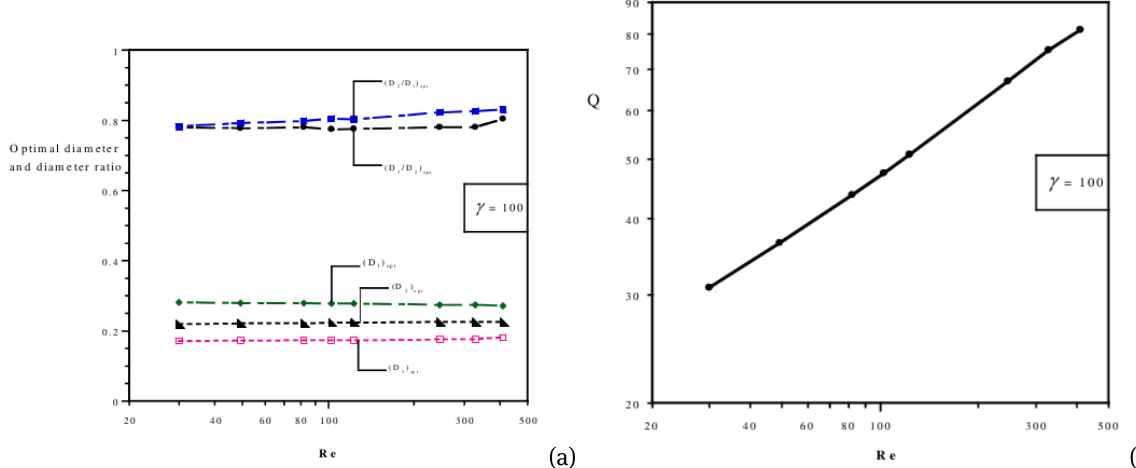
Figure 4: (a) The relationship between the optimal configurations for each fin row as a function of Reynolds number for triple rows for a thermal conductivity ratio of 100. (b) The relationship between the optimal dimensionless rate of heat transfer and Reynolds number for a triple row heat sink for a thermal conductivity ratio of 100.